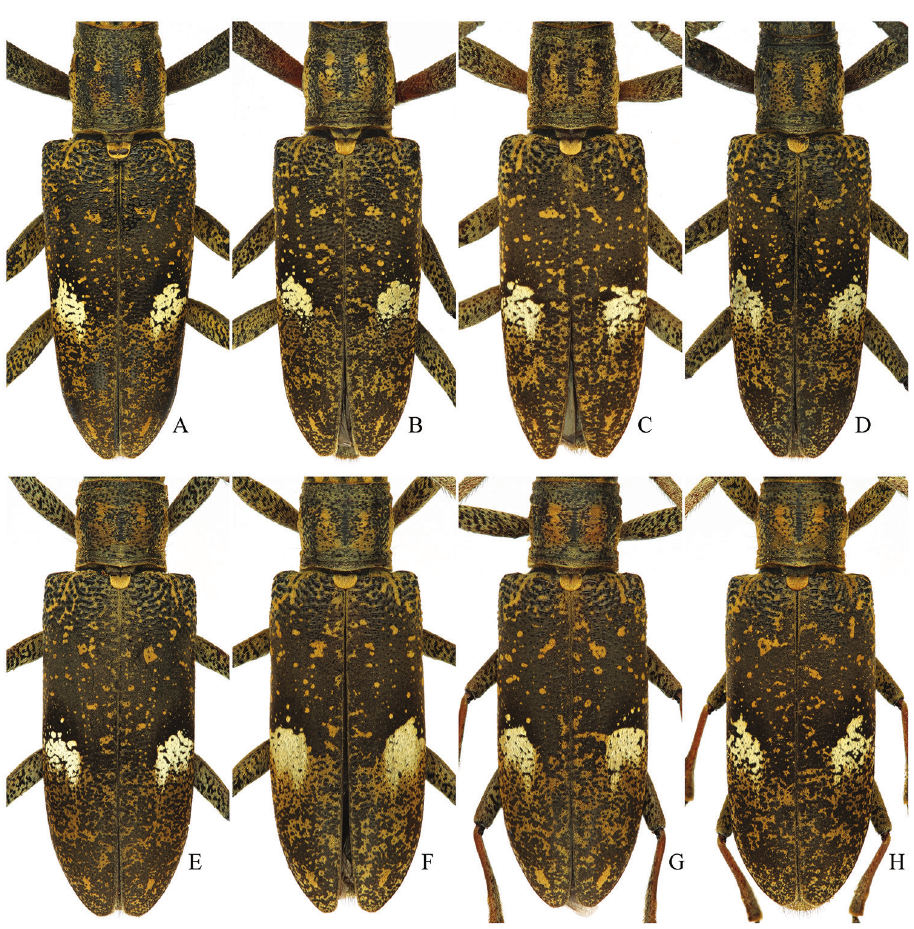
Figure 2. Variations of pubescence and spots on the elytra of Pseudomacrochenus wusuae sp. n. (paratypes; dorsal view) A–D ♂♂, E–H ♀♀